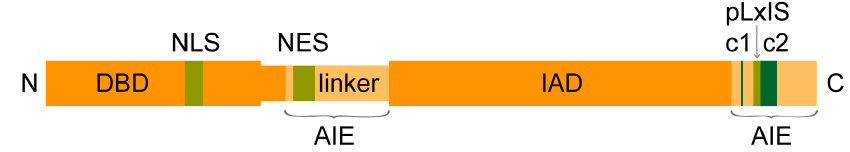
Figure 1. Schematic representation of the transcription factor interferon regulatory factor 3 (IRF3) . IRF3 consists of an N-terminal DNA-binding domain (DBD) linked by a flexible region to the C-terminal IRF association domain (IAD). In the latent state, a part of the linker and the most C-terminal portion form auto-inhibitory elements (AIEs). Phosphorylation of two serine-rich clusters (c1 and c2) induces conformational rearrangements of the AIEs and frees the IAD to participate in protein–protein interactions with coactivators and for dimerisation via the phosphorylated pLxIS motif (p: hydrophilic, x: any amino acid). The protein further contains a nuclear localization signal (NLS) and a nuclear exit signal (NES) that enable constitutive shuttling between the cytosol and nucleus.